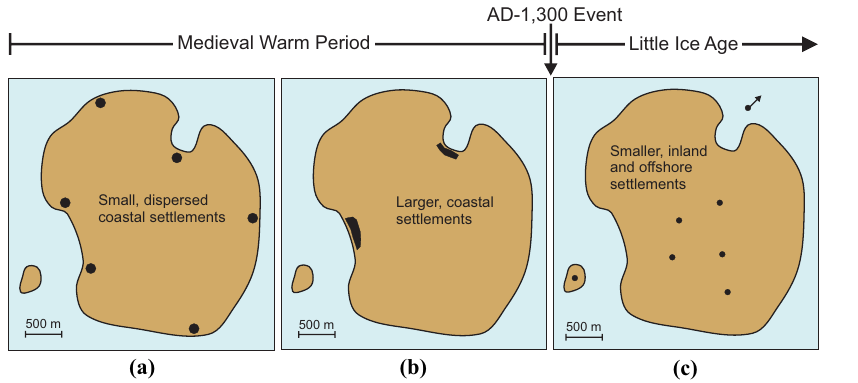
Figure 1. Typical